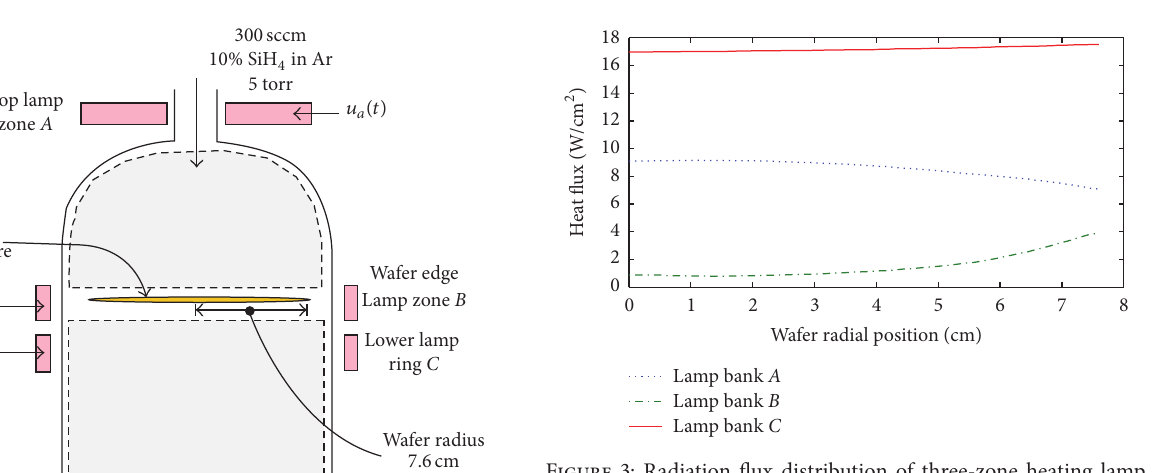
Figure 3: Radiation flux distribution of three-zone heating lamp